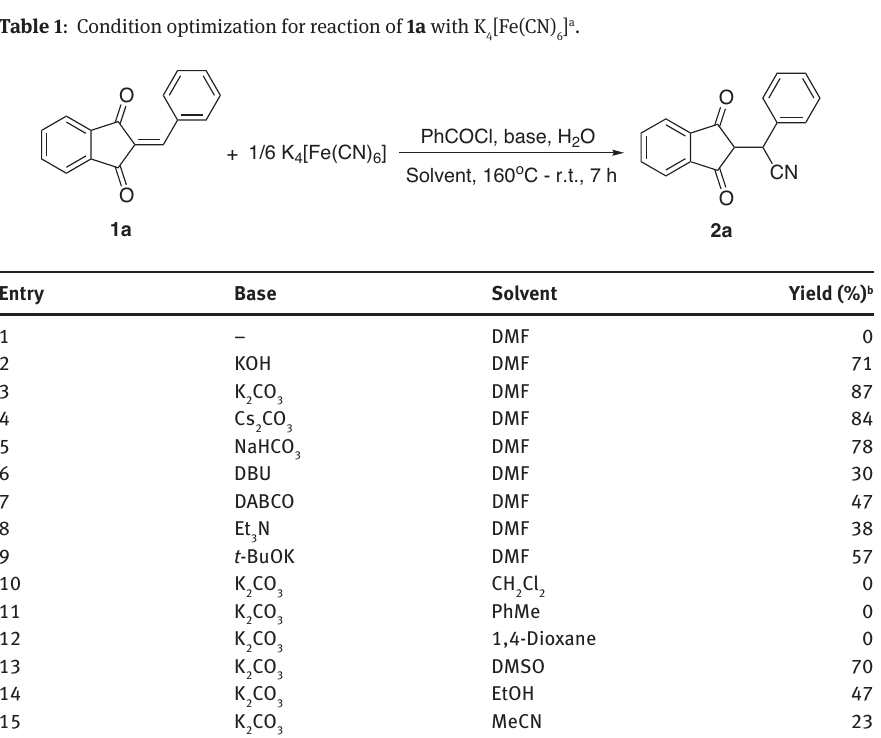
Table 1 : Condition optimization for reaction of 1a with K